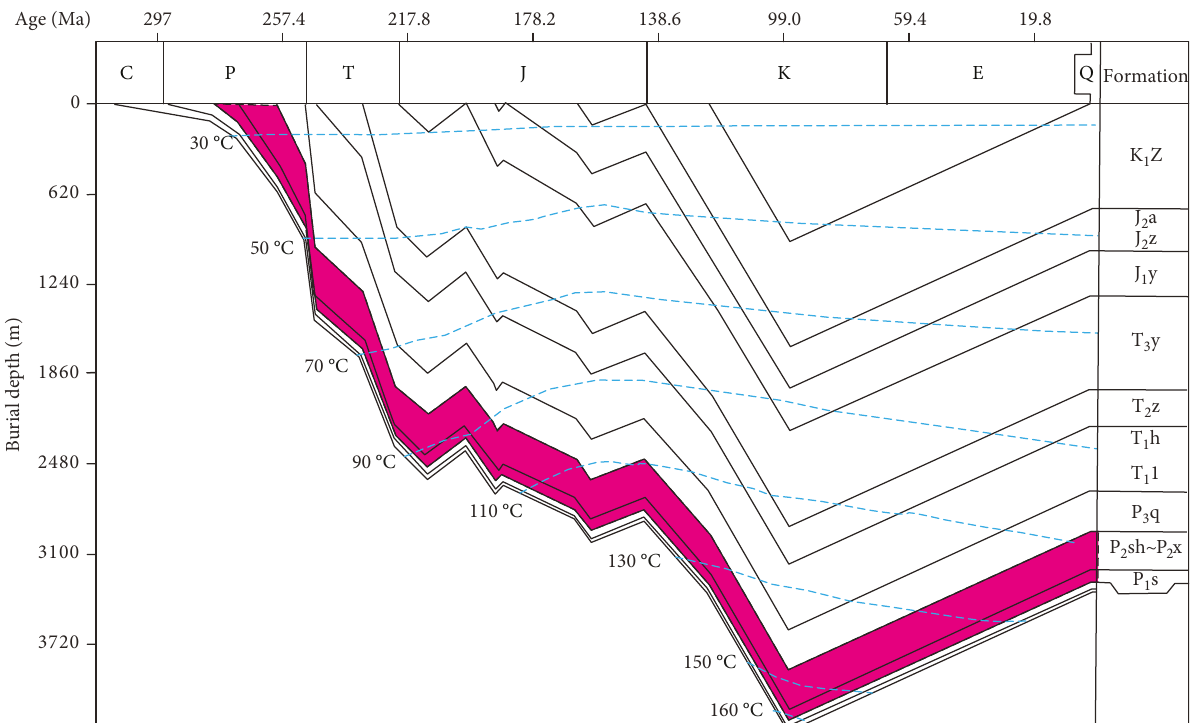
Figure 4: Burial and geothermal history in the Shanxi and Shihezi Formation sandstones in the Su15 well (modi fi ed after